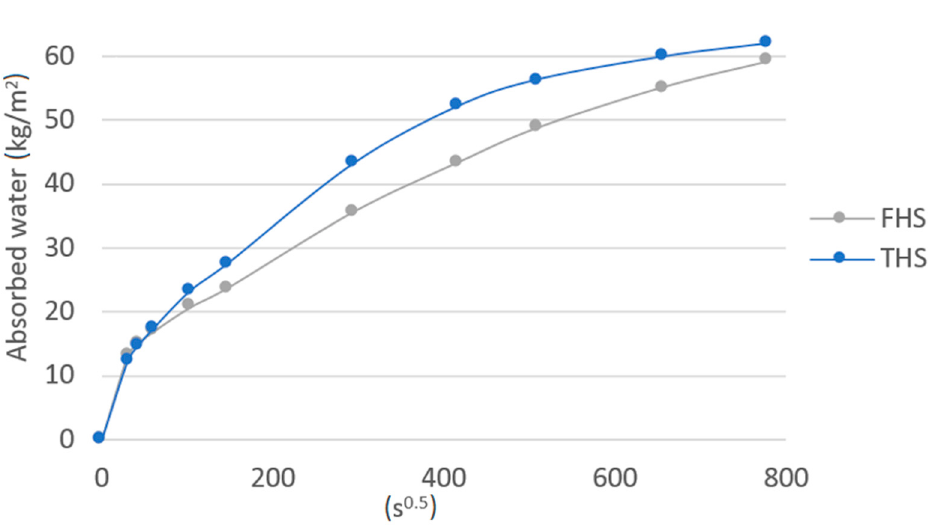
Figure 3. Capillary uptake of tested composites.